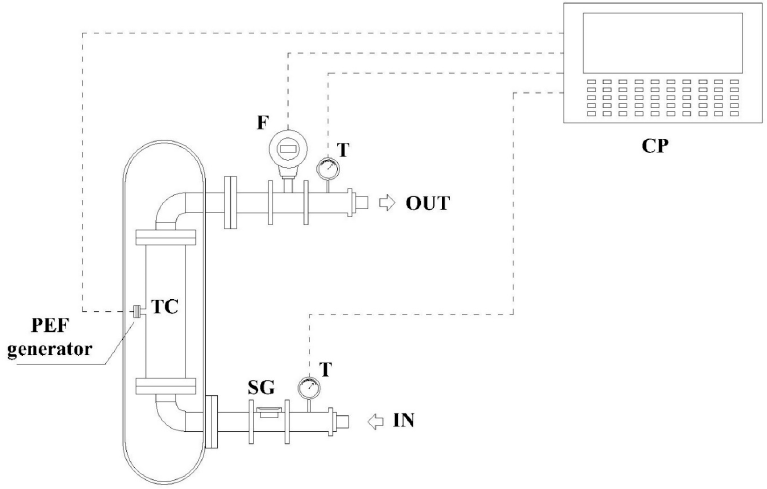
Figure 1. The Pulsed Electric Field (PEF) device. IN—paste flow Input; OUT—paste flow Output; TC—Treatment Chamber, T—Temperature probe; F—Flowmeter; SG—Sight Glass; and CP—Control Panel.